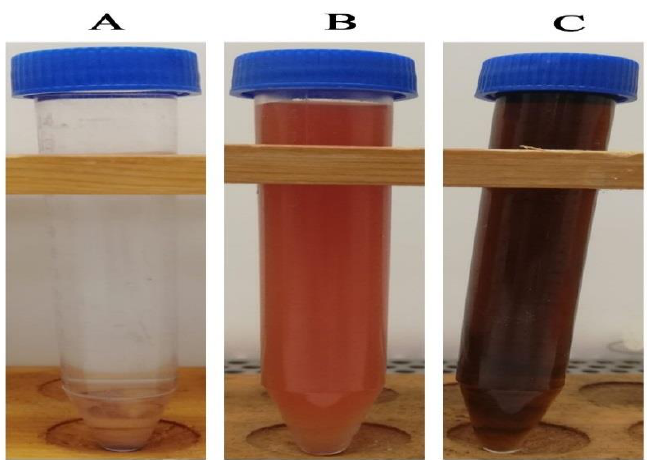
Figure 1. Change of color silver nitrate solution after addition of pomegranate peel extract confirming the biosynthesis of silver nanoparticles. (( A ) colorless silver nitrate solution; ( B ) pomegranate peel aqueous extract; ( C ) the biosynthesized AgNPs).